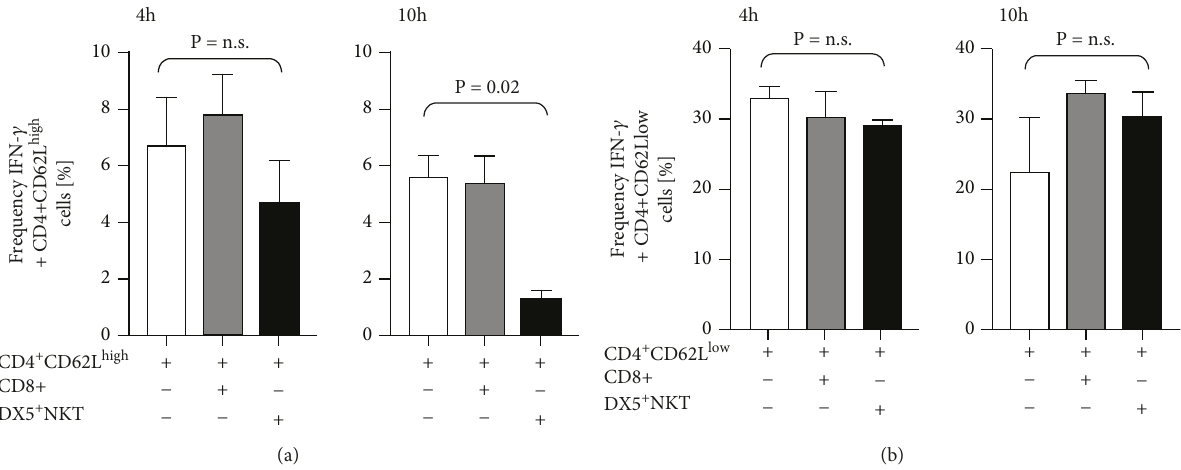
cells (b) after 4h and 10 h of low